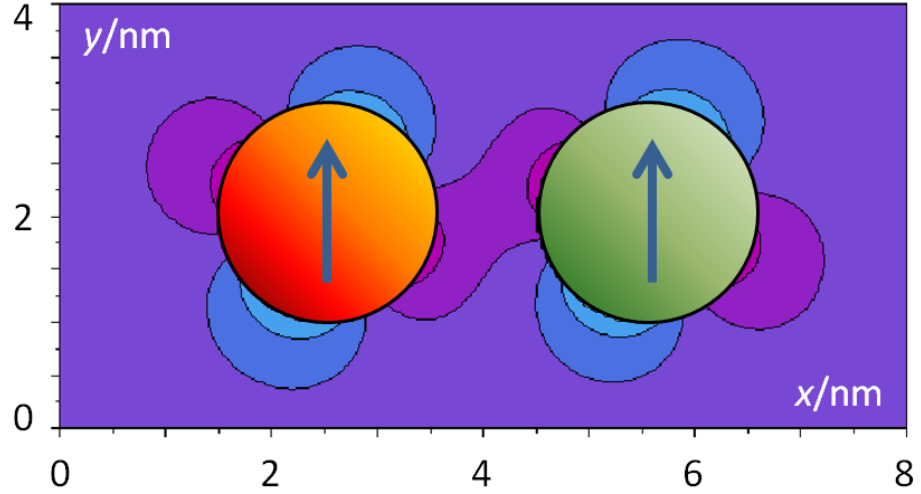
Figure 6. Influence of neighbouring dipole position on the rate of energy transfer between two chromophores. Here, the chromophore transition moments are aligned parallel to the y -axis, the ancillary dipole at an angle of π /4 to the y -axis. The influence on the RET rate is diminished in the blue regions, increased in the red regions—up to a 200% increase of rate over the lightest blue